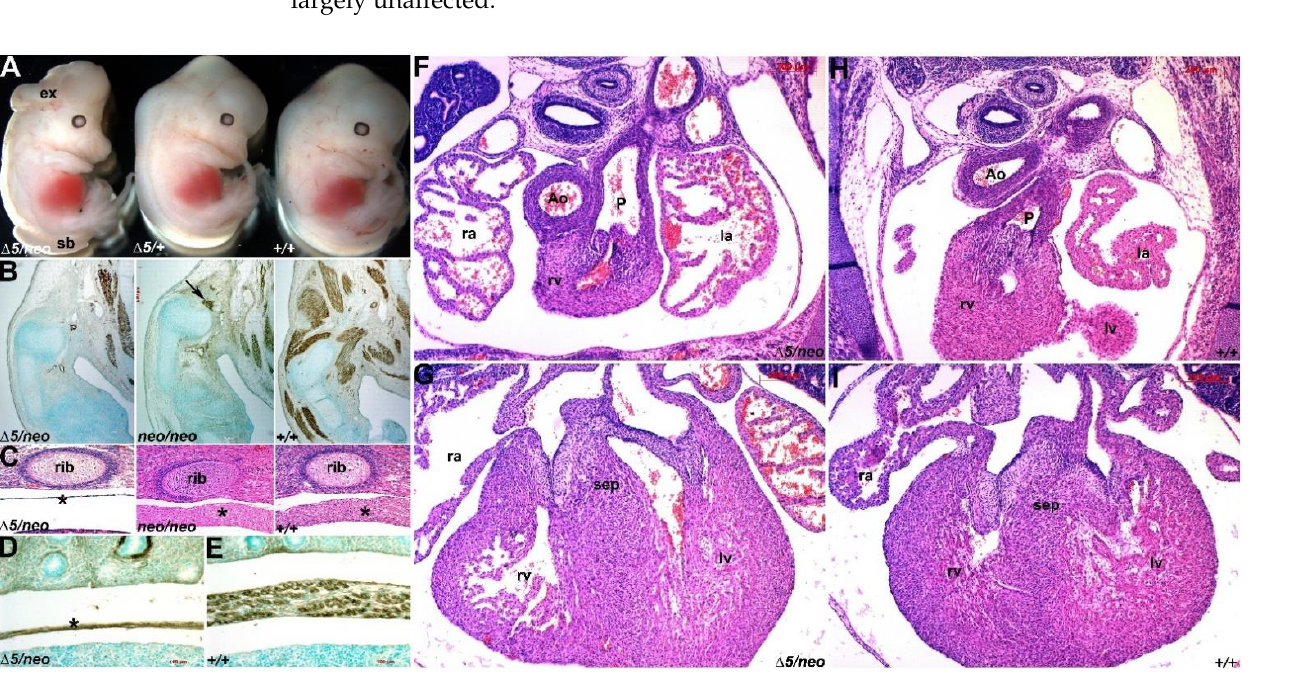
Figure 1. Pax3 ∆ 5/neo hypomorphic mutants do not exhibit any CHDs. ( A ) Whole fetal views of E14 Pax3 ∆ 5/neo , Pax3 ∆ 5/+ and wildtype (+/+) littermates, reveals presence of spina bifida (sb) and exencephaly (ex) neural tube defects in only Pax3 ∆ 5/neo mutants. ( B ) Immunohistochemistry using αSmooth muscle actin (brown) at shoulder level in three fetuses depicted in ( A ), detects the muscle lineage. Note in a gene dosage-responsive style, there is a complete absence of limb musculature in Pax3 ∆ 5/neo , and a severe reduction in Pax3 ∆ 5/+ compared to normal musculature in the wildtype littermate. Fibers of the triceps brachii (arrow in middle panel) are still present but the extensor and flexor muscles of the forelimb are missing in Pax3 ∆ 5/+ embryos. ( C ) (H,E) staining of the diaphragm at E17.5. While the thickness of diaphragm is similar in Pax3 neo/neo and +/+, further reduction in Pax3 resulted in hypoplastic Pax3 ∆ 5/neo diaphragm (*). ( D , E ) Immunohistochemistry using αSmooth muscle actin revealed robust musculature in both wildtype diaphragms, but a lack of myofiber arrangement in Pax3 ∆ 5/neo mutants. ( F – I ) (H,E) analysis of E15.5 hearts at both outflow tract and interventricular septum (sep) levels revealed that Pax3 ∆ 5/neo mutant hearts are grossly unaffected by the ~90% reduction in Pax3 levels. Both the wildtype ( H , I ) and Pax3 ∆ 5/neo ( F , G ) hearts exhibit separate aorta (Ao) and pulmonary trunks (P) and normal ventricular septation, as well as similar normal valvular structures. Abbreviations: ra, right atria; la, left atria; rv, right ventricle; lv, left ventricle. Scale ( B ), 500 μm; ( C – E ) , 100 μm; ( F – I ) , 200 μm.